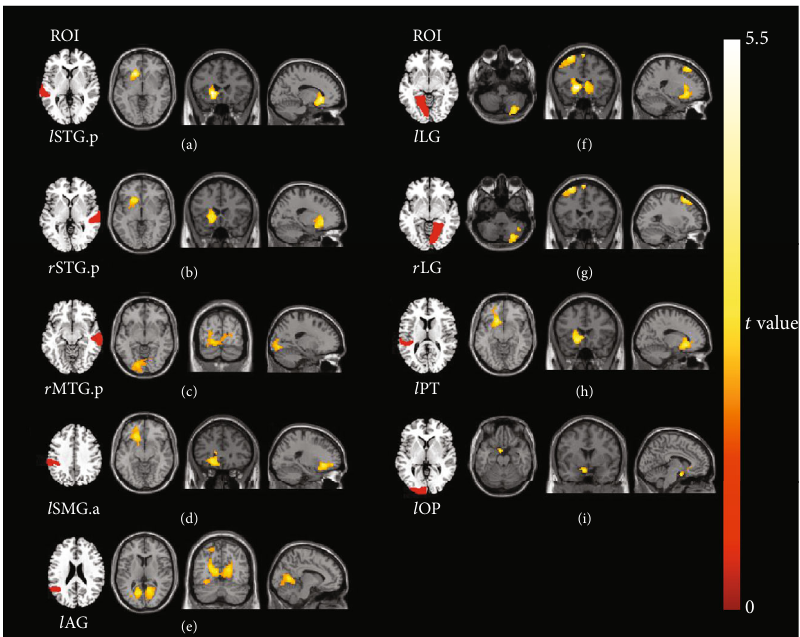
Figure 2: Intergroup comparisons of voxel-wise FC between the SSNHL and HC groups. Compared with the HC group, the SSNHL group showed signi fi cantly increased voxel-wise FC values in nine ROIs, including (a) the l STG.p and a cluster located in the left putamen and left caudate nucleus, (b) the r STG.p and a cluster located in the left putamen and left caudate nucleus, (c) the r MTG.p and a cluster located in the bilateral lingual gyri and the right calcarine cortex, (d) the l SMG.a and a cluster located in the left inferior frontal gyrus, (e) the l AG and a cluster located in the bilateral calcarine cortex and left posterior cingulate cortex, (f) the l LG and three clusters located in the right cerebellum posterior lobe, left caudate nucleus, and left MFG, (g) the r LG and two clusters located in the right cerebellum posterior lobe and left MFG, (h) the l PT and a cluster located in the left caudate nucleus and left putamen, and (i) the l OP and a cluster located in the left caudate nucleus and left putamen. The color bar indicates the t -value of voxels with signi fi cant intergroup di ff erences. STG: superior temporal gyrus; MTG: middle temporal gyrus; SMG: supramarginal gyrus; AG: angular gyrus; LG: lingual gyrus; PT: planum temporale; OP: occipital pole; l : left; r : right; a: anterior division; p: posterior division. Table 3: The peak MNI coordinates and intensity of brain clusters with signi fi cant intergroup di ff erences in voxel-wise FC values. ROI Brain region MNI coordinates x , y , and z Number of voxels Peak intensity l STG.p L putamen/L caudate nucleus